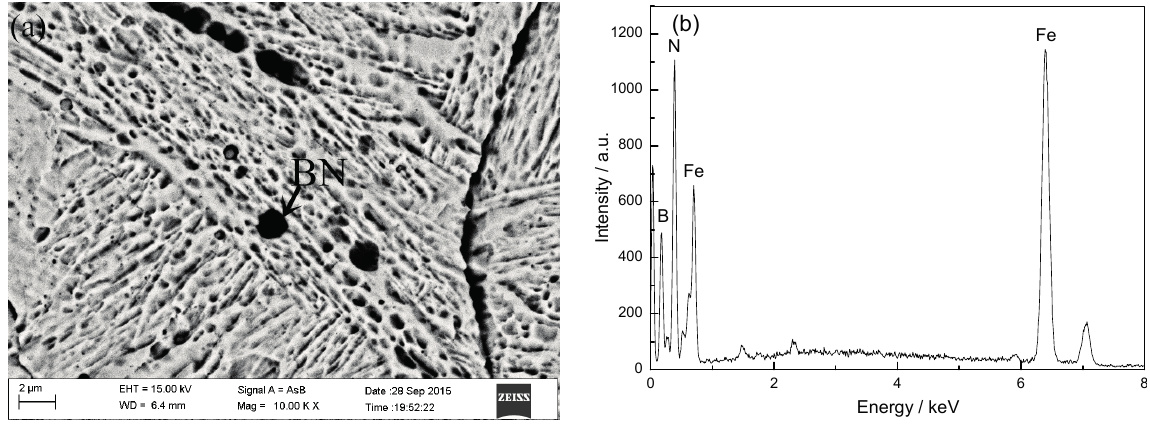
Figure 3. The ∆ G θ of producing AlN, BN, and TiN at different temperatures.